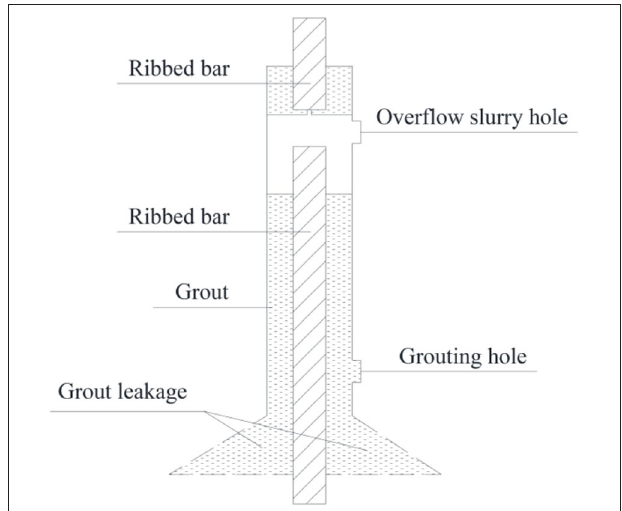
FIGURE 2 | Incomplete fill of grout sleeve defect caused in on-site construction.